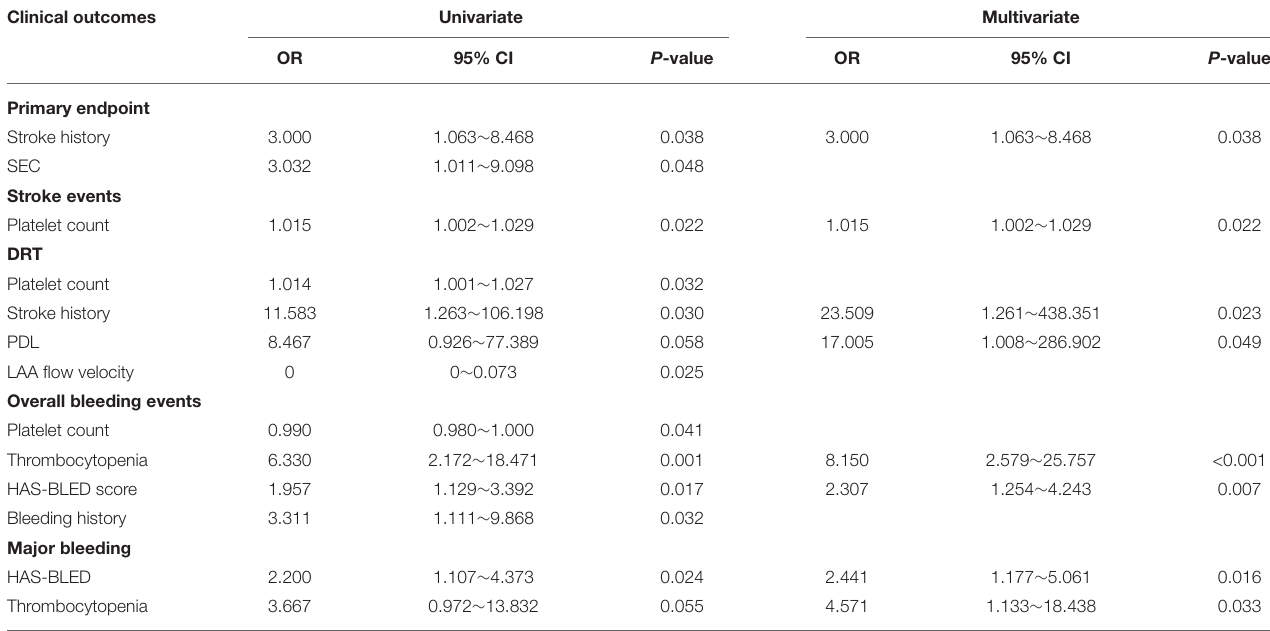
TABLE 4 | Univariate and multivariate analysis of the stroke, bleeding, and other endpoints. Clinical outcomes Univariate